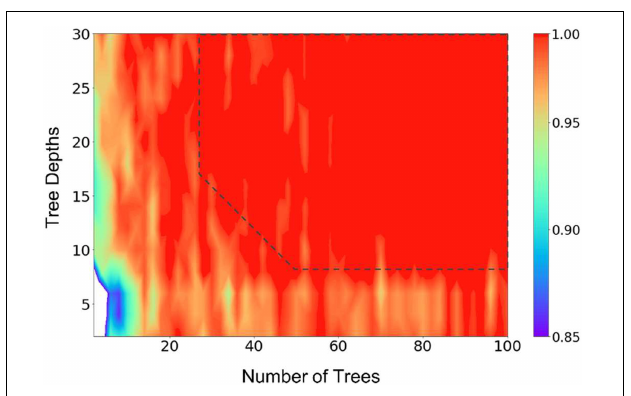
FIGURE 1 | Results of a grid search of the number of trees and tree depths of the random forest model, illustrating the hyperparameter tuning processes. The number of bins were fixed at 32 in the calculations. The prediction accuracy was represented by the scale of the colors showing on the right side. The dashed line (drawn manually to serve as a guide to the eye) represents the approximate point where the prediction accuracies plateaued.